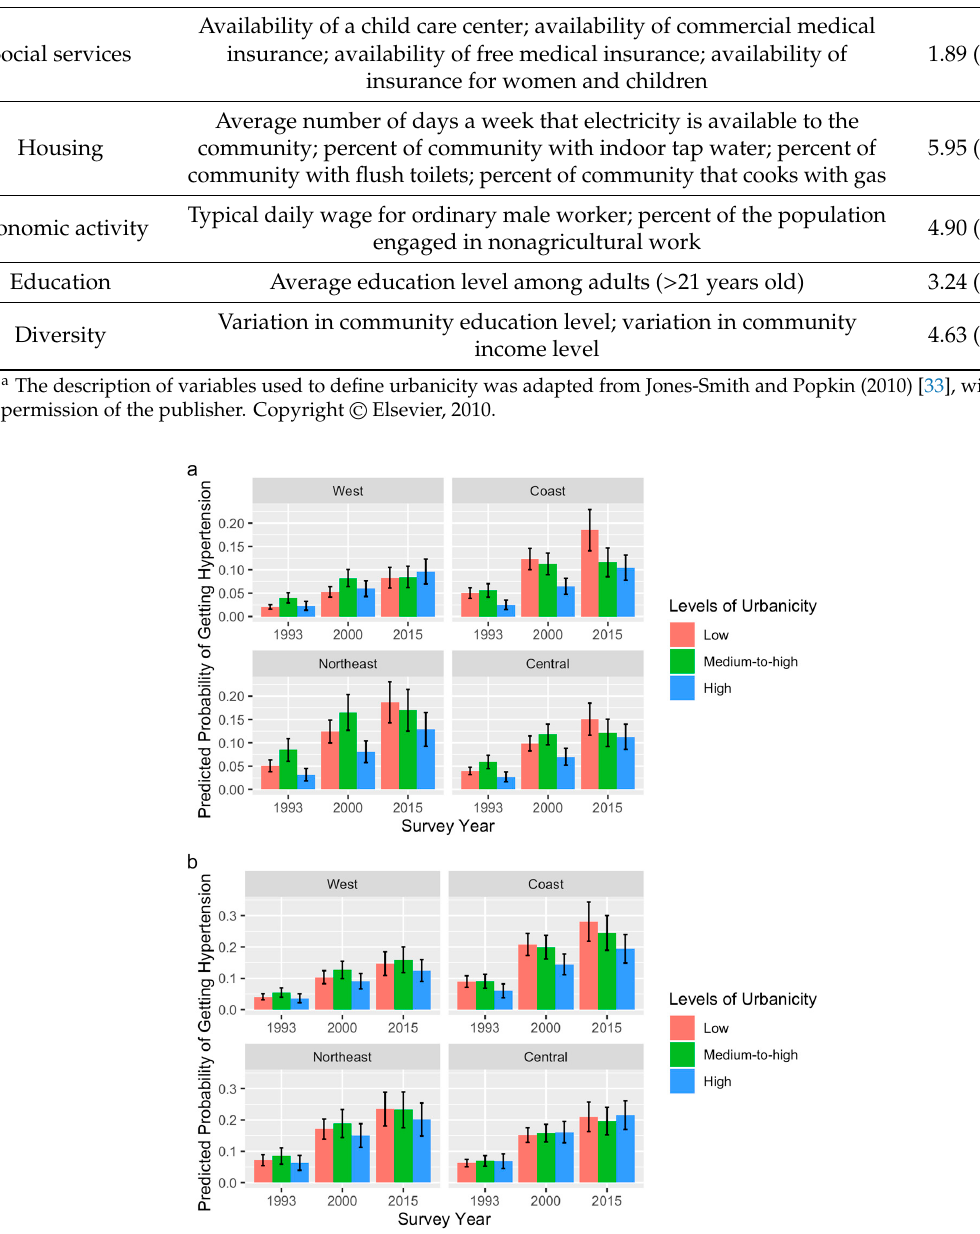
Figure A1. Predicted probabilities of getting hypertension and 95% confidence interval during 1991–2015 among women ( a ) and men ( b ) by levels of urbanicity, region, and survey year.